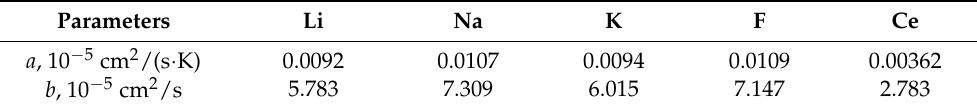
Table 3. Parameters a and b for linear Equation